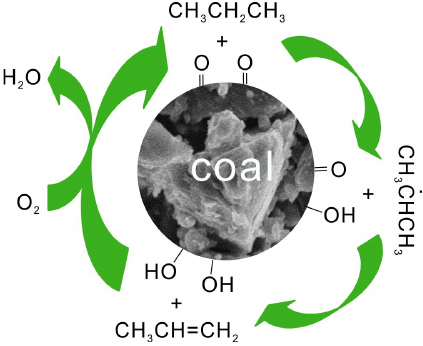
Figure 8. Scheme of proposed mechanism for catalysis of propane to propene by coal.